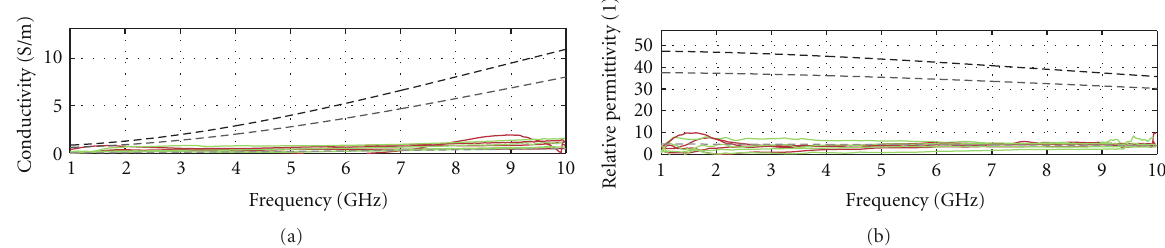
Figure 15: Estimation of breast tissue electrical properties (conductivity in (a) and permittivity in (b)) for the 35-, 36-, 43(a)- and 65-year- old volunteers. Groups 1, 2, and 3 refer to the glandular, transition, and fatty categories of tissues defined in